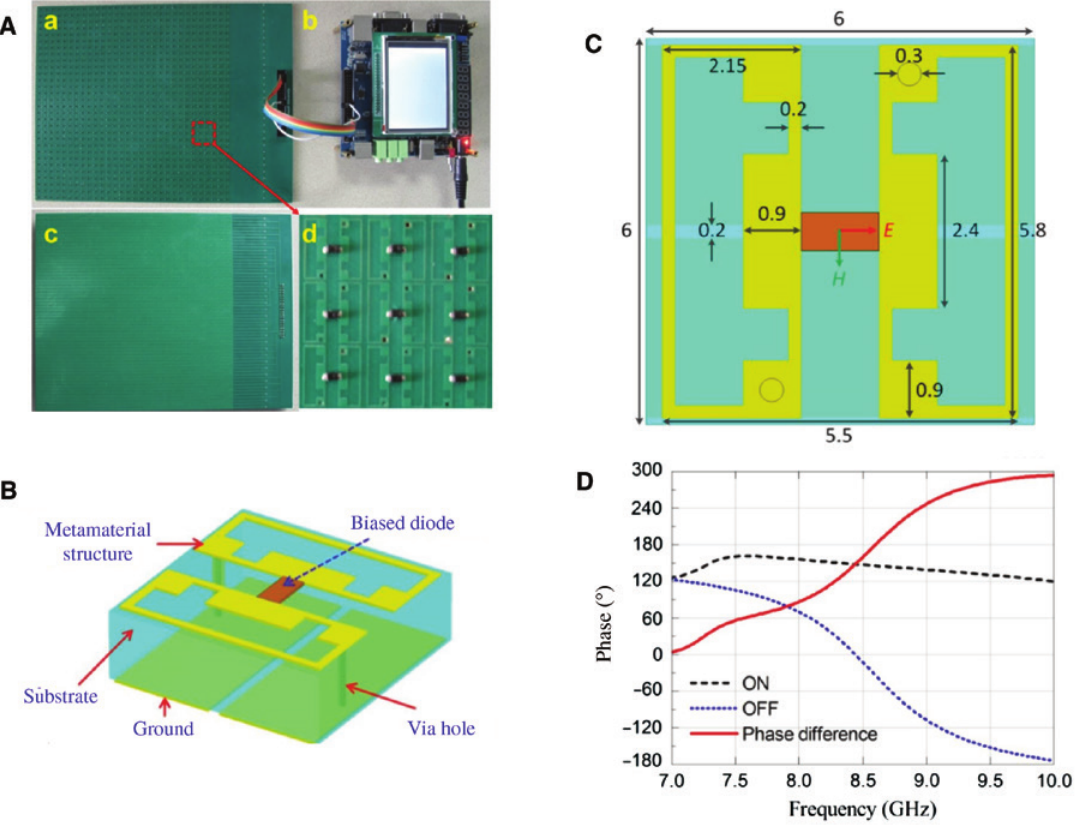
Figure 1: The first proposal of information metamaterials (called programmable metasurface in [24]) at microwave. (A) The fabricated reflection-type information metasurface controlled by FPGA in a 1D way, where Figure sub-(a) is the top view of the information metasurface. Figure sub-(b) is the used FPGA. Figure sub-(c) is the bottom view of the information metasurface. Figure sub-(d) is the zoomed view of information metasurface. (B) The geometrical structure of unit cell, which behaves as “0” and “1” elements when the biased diode is “Off” and “On.” (C) Top view of the meta-atom to realize information metasurface, in which the detailed geometrical parameters are given. (D) The frequency-dependent phase responses of the digital meta-atom as the biased diode is “Off” and “On” in a range of frequencies. Adapted from